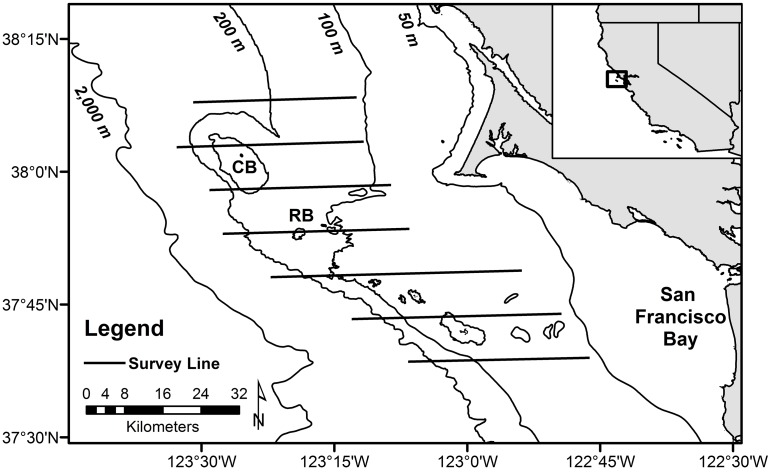
Map of study area showing the replicate transect lines surveyed and important bathymetric features.Cordell Bank (CB) and Rittenburg Bank (RB) are delineated by the extent of the 100 m isobath.